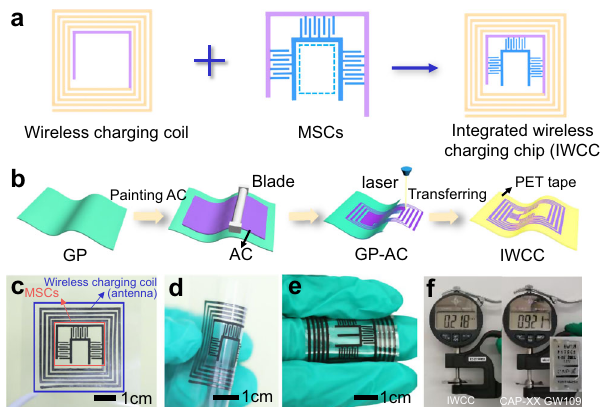
Fig. 1 The design, fabrication, and electronic photos of IWC-MSCs. a Combination of WCC and MSCs in the integrated device, IWC-MSCs. b The schematic illustration of fabricating the integrated device. c The optical image of the integrated device IWC-MSCs. d Flexibility demonstration of the integrated device IWC-MSCs at a highly folded state. e The optical image of the integrated IWC-MSCs wrapping around one fi nger. f Thickness comparison of the IWC-MSCs with the thin-type commercial capacitor (CAP-XX GW109). The inset is the top view of the CAP-XX GW109. IWCC means the integrated wireless charging